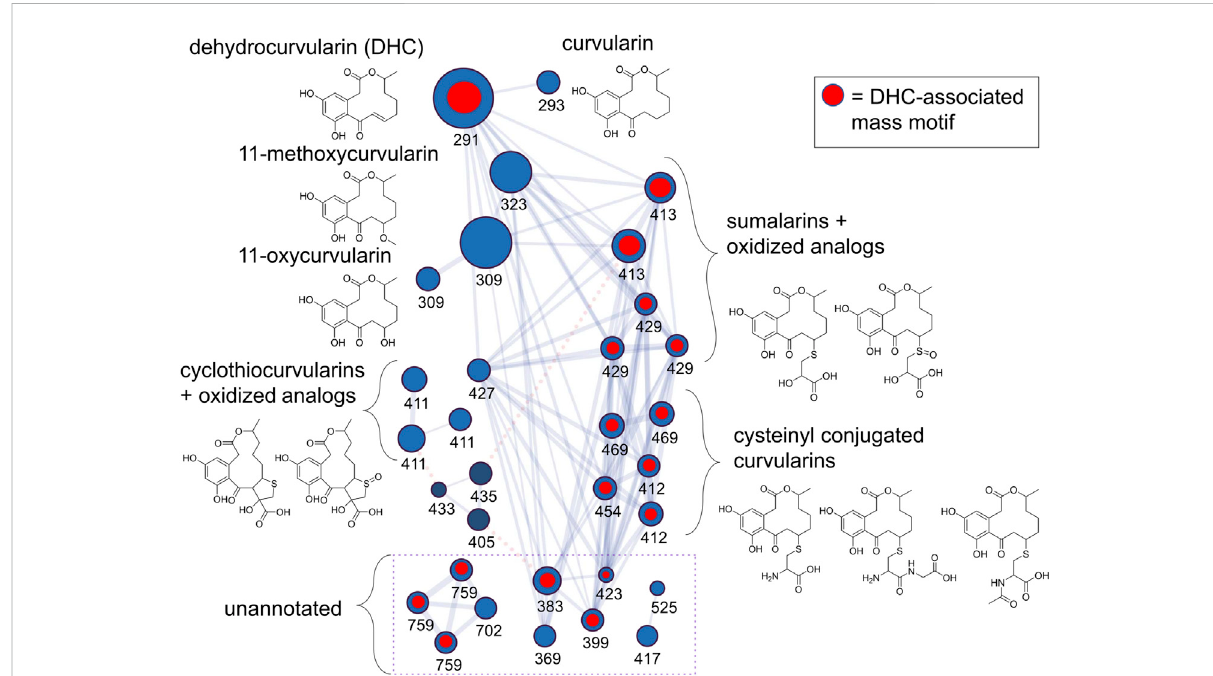
FIGURE 2 Dehydrocurvularins, sumalarins and related molecules annotated by analysis of MS 2 fragmentation data from an extract of isolate DET2035. Nodes (circles) represent mass features, where size is proportional to the ion precursor intensity, and are labeled by their nominal mass (see Table 2 for exact masses and annotation details). Nodes are linked with a blue line if their MS 2 spectra share a minimum of 6 fragment ions, and a cosine score > 0.75.Nodeslinkedwithadottedredlinerepresentputativeadductsofthesamemolecule(linked via theionidentitynetworkingmodule of MZMine2, see methods), and were not collapsed in the network in order to show connectivity between the cyclothiocurvularins and the other signals in the cluster. Blue nodes represent [M+H] + adducts and dark blue nodes represent [M+Na] + adducts. Structures drawn are hypothetical annotations based on exact mass and MS 2 -analysis. The network is derived from the GNPS feature based molecular network analysis work fl ow incorporating a mix of manually annotated ion identities, and MZMine2-derived ion